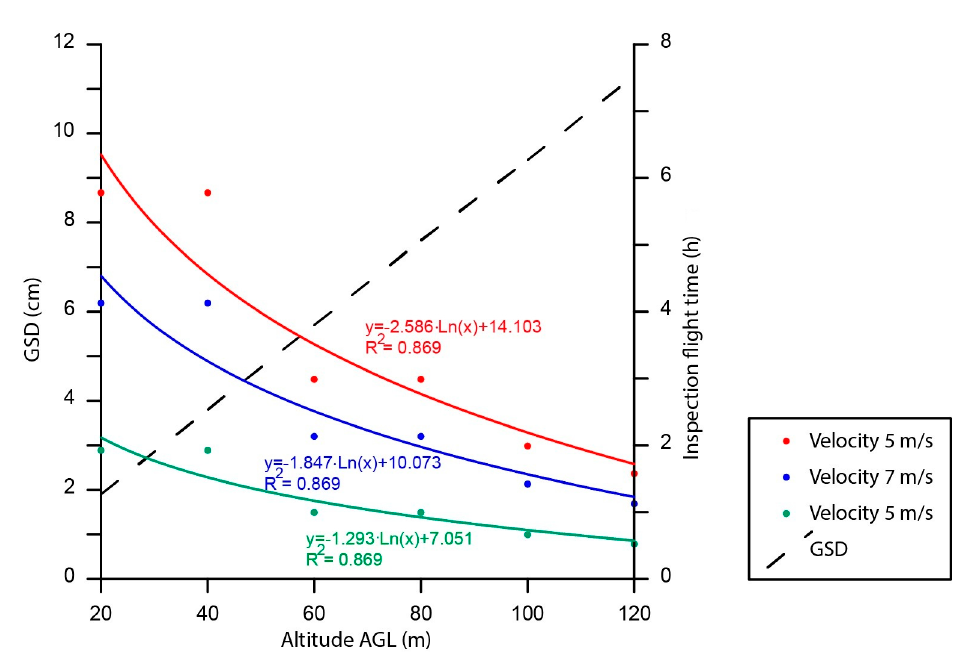
Figure 8. Inspection flight time considering cruising speed and altitude AGL.